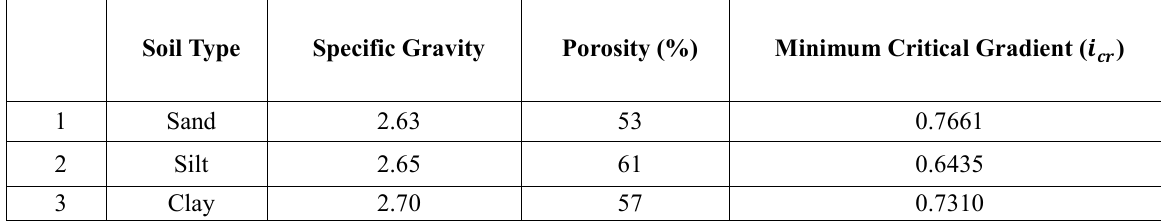
Minimum critical gradient for sand, silt, and clay